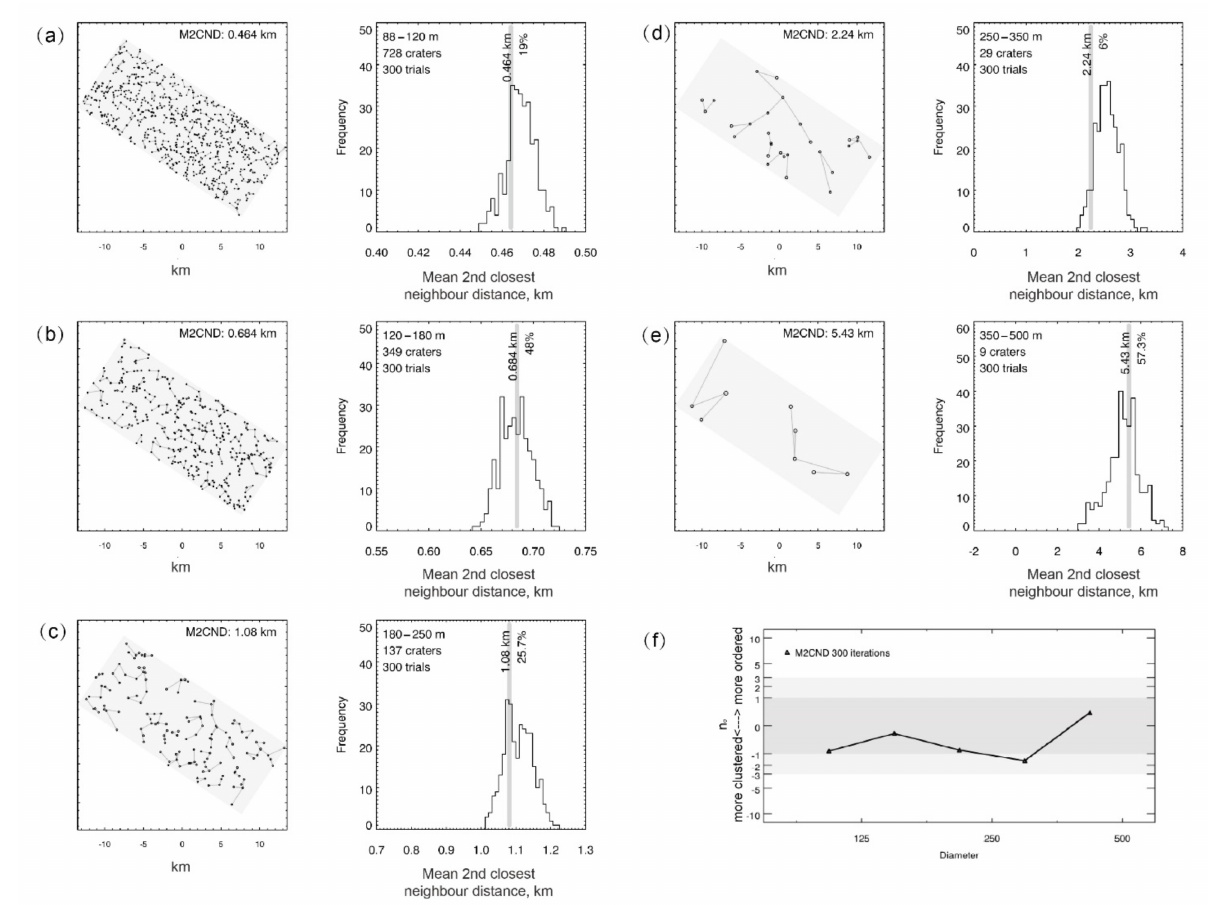
Figure 9. ( a – e ) show the clustering analysis for five consecutive diameter bins of craters in Em4c. Craters are shown to scale with line segments connecting 2nd-closest neighbors. The measured mean 2nd-closest neighbor distance (M2CND) is plotted with respect to the Monte Carlo M2CND histogram for simulated random scatterings of the same crater catalog [47]. ( f ) n sigma plot of M2CND all the diameter bins.